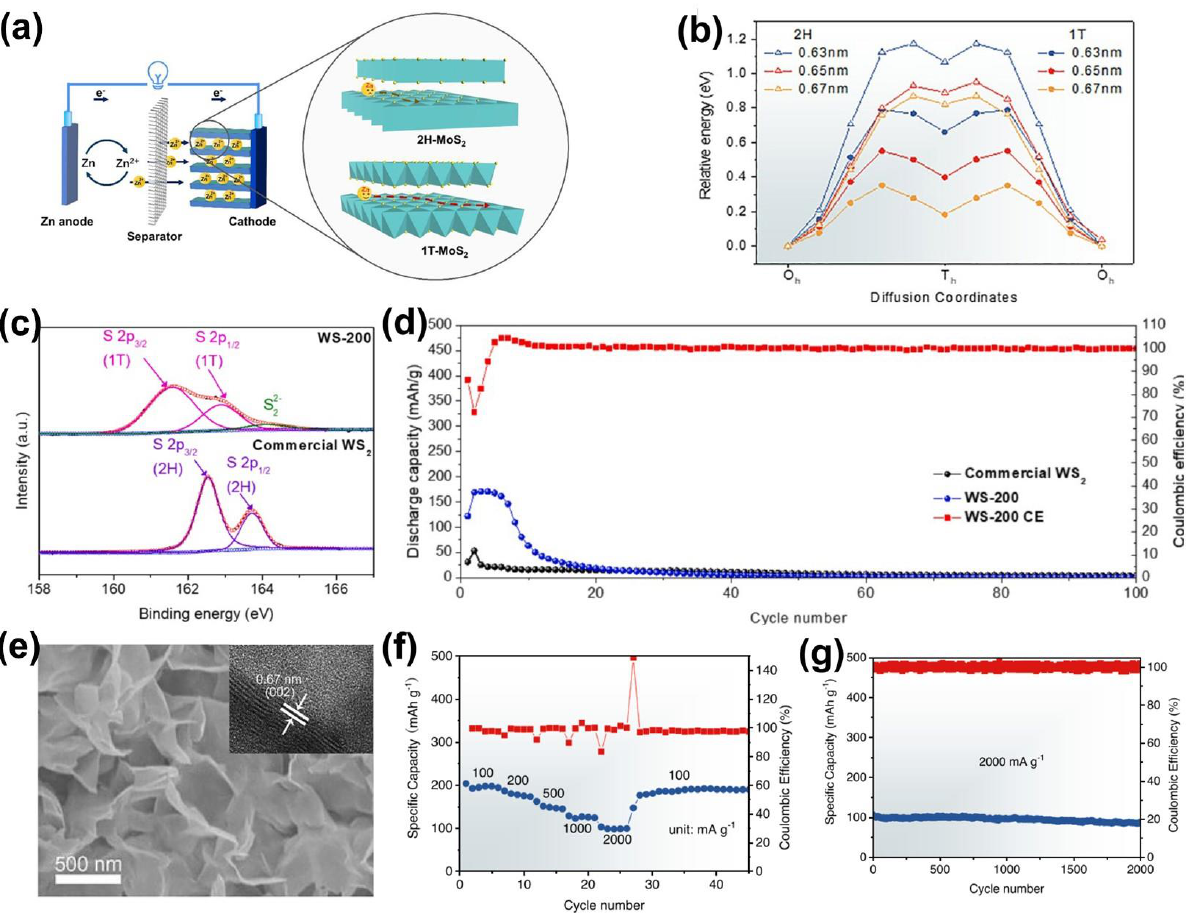
Figure 3. Phase − engineered TMDs for ZIB cathode. ( a ) Illustration of the rechargeable Zn/MoS 2 battery system. ( b ) Relative Zn 2+ diffusion energies associated with the interlayer spacing in 2H and 1T MoS 2 . Reprinted with permission from Ref. [14]. Copyright 2020, Elsevier. ( c ) High − resolution XPS spectra of S 2p in the commercial WS 2 and WS 2 − 200 (1T − WS 2 ) samples. ( d ) Galvanostatic charge/discharge curves of WS 2 − 200 with various current densities. Reprinted with permission from Ref. [29].